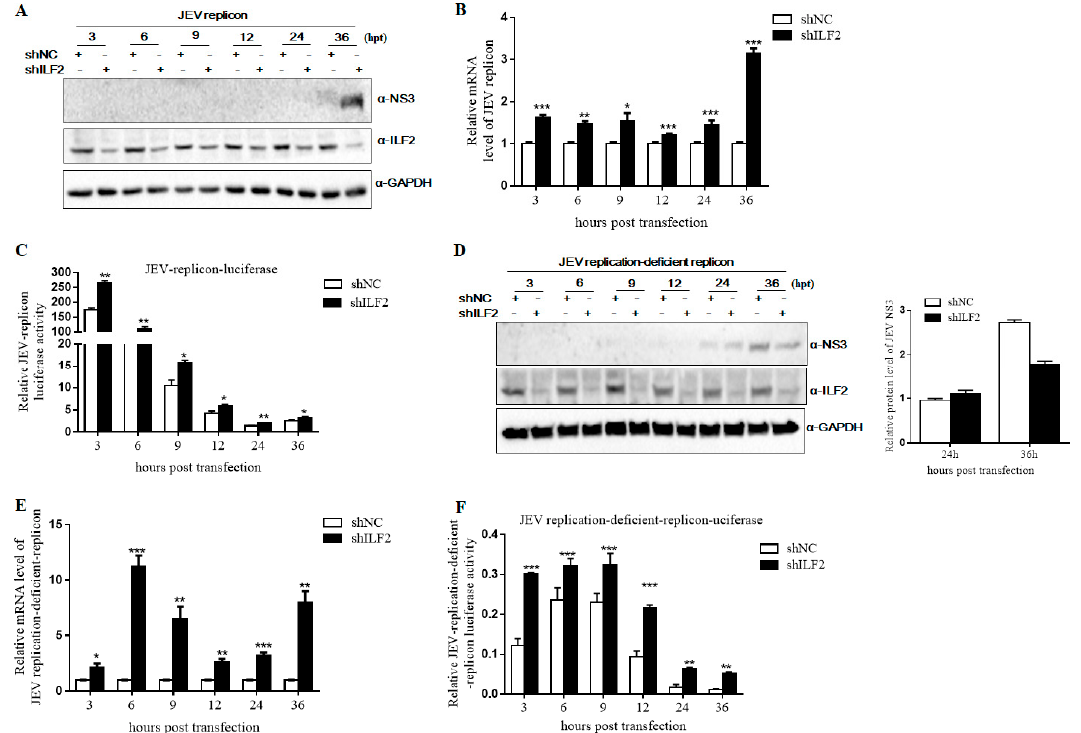
Figure 7. Knockdown of ILF2 positively regulates JEV replication by sub-genomic replicon system assay. 293T-shILF2 cells and 293T-shNC cells were transfected with a Renilla luciferase JEV replicon RNA or a Renilla luciferase JEV replication-deficient replicon DNA. Firefly luciferase was used as the internal control. Cells lysates were harvested at 3, 6, 9, 12, 24, and 36 h post-transfection (hpt). ( A , D ) The protein level of JEV NS3 was determined by Western blot analysis with antibodies against JEV NS3, ILF2, and GAPDH. GAPDH served as the loading control at an equal sample loading. ( B , E ) Total cellular RNA was extracted and the level of JEV RNA (NS3) was detected through real-time PCR analysis. ( C , F ) Cell lysates were collected at the indicated times and were subjected to dual-luciferase assay. Renilla luciferase activity was normalized to firefly luciferase. The data shown are from three independent assays, with the error bars representing standard deviations (* p < 0.05; ** p < 0.01; *** p < 0.001, Student’s t -test).